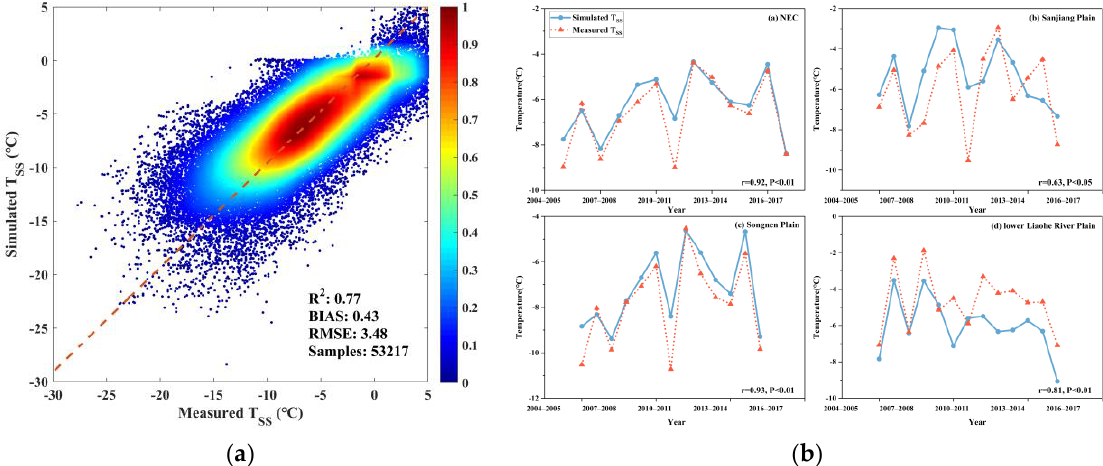
Figure 3. ( a ) The color–density scatterplots of simulated T SS and measured T SS ; the color bar represents the distribution density of the scatterplots, the greater the density, the more concentrated the distribution scatterplots; ( b ) the trends of year-to-year fluctuations between the model and the actual measurement during 2005 to 2018 of NEC and the Sanjiang Plain and Songnen Plain and lower Liaohe River Plain.